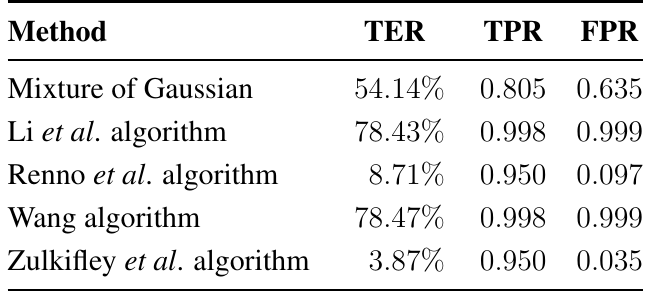
Table 3. Performance comparison between the methods for the first video.